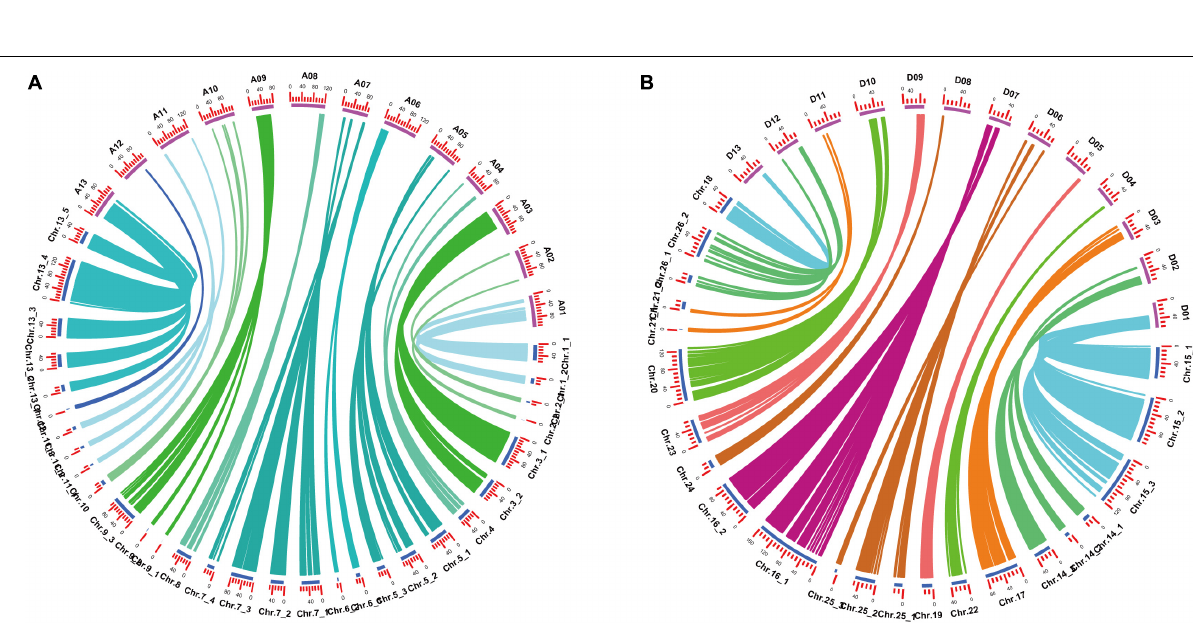
Frontiers in Plant Science |